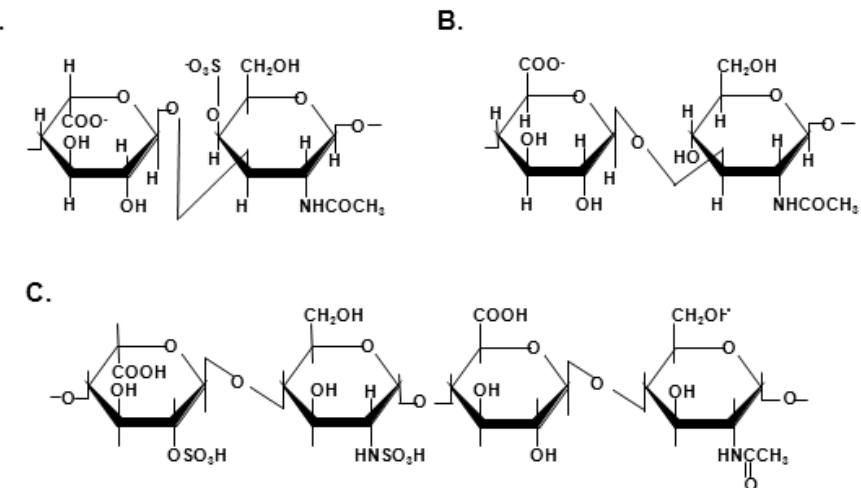
FIGURE 2. Structural formulas of GAGs up-regulated in CF. Structures represent the repeating units of chondroitin sulphate B (A), HA (B), and HS